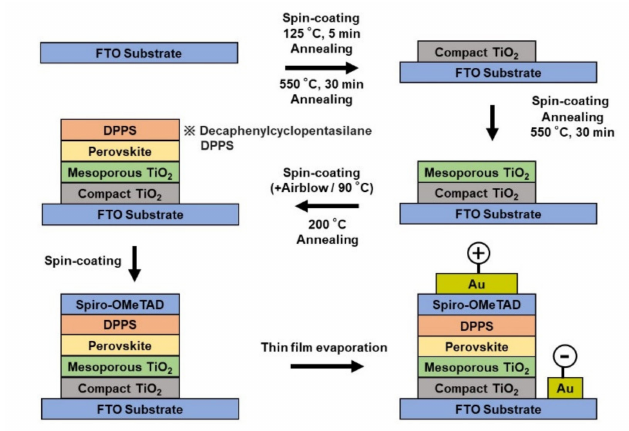
Figure 1. Schematics the processes for the PSC